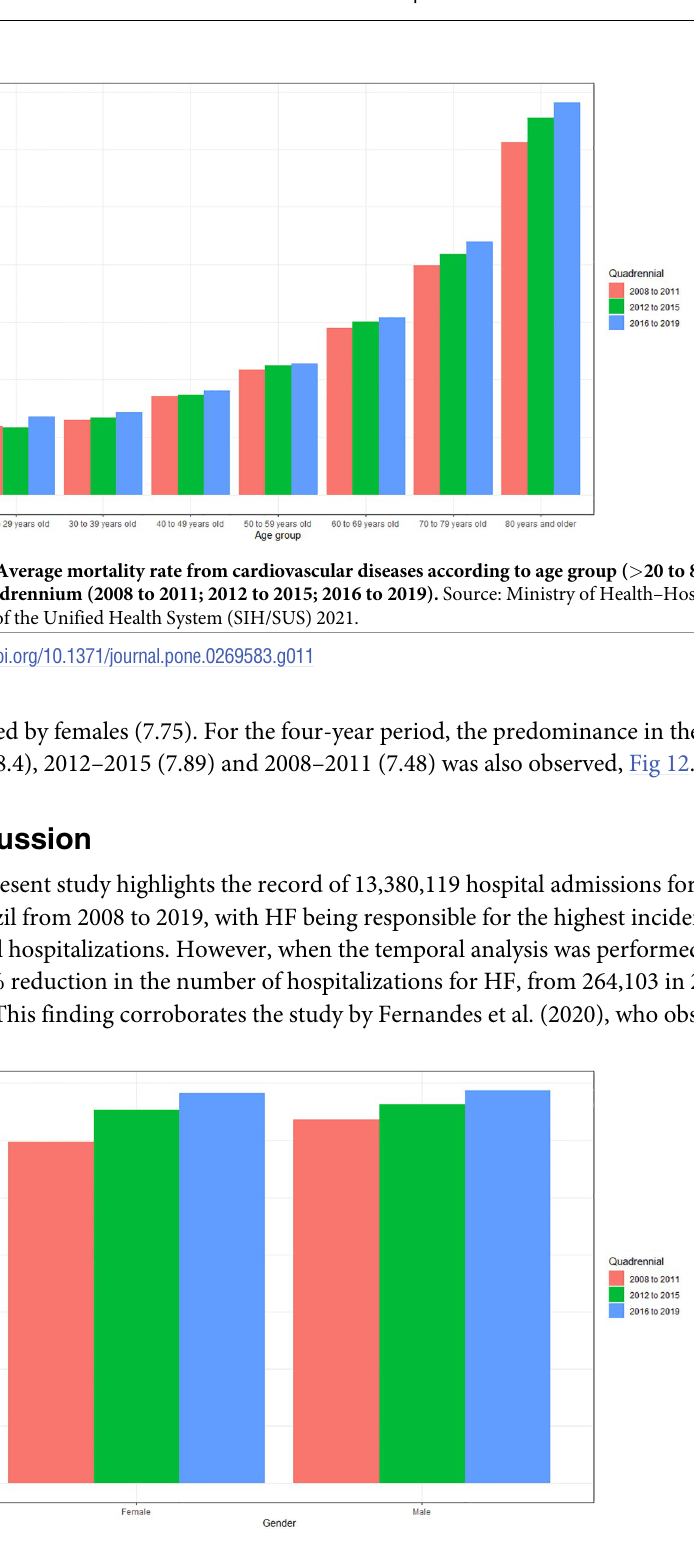
Fig 12. Average mortality rate from cardiovascular diseases according to gender and quadrennium (2008 to 2011; 2012 to 2015; 2016 to 2019). Source: Ministry of Health–Hospital Information System of the Unified Health System (SIH/SUS)